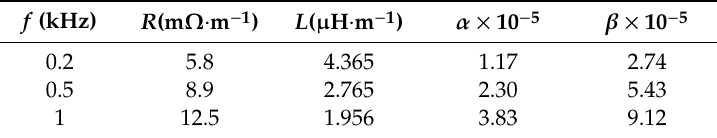
Table 1. Specific measurement parameters and calculation results.